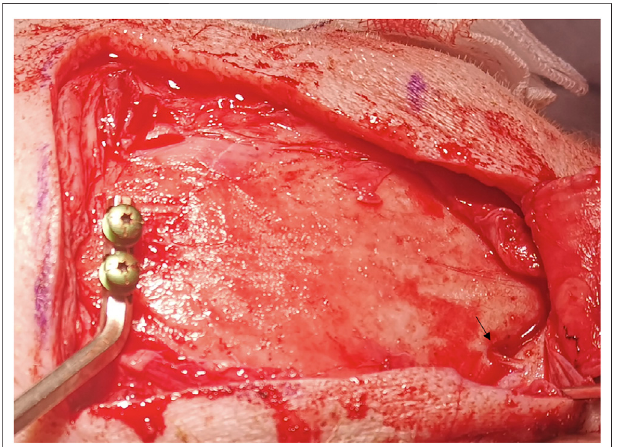
FIGURE 2 | Exposing the supraorbital nerve (arrow) for registration